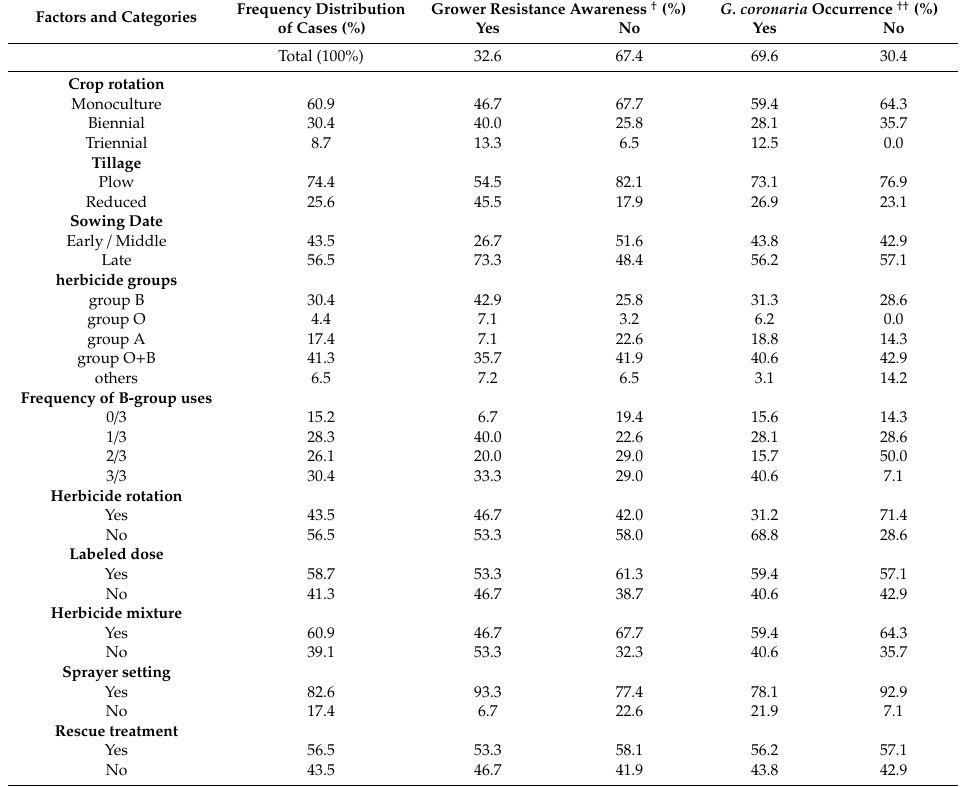
Table 1. Frequency distribution of cases (%) within each category of analyzed factors (cultural and management factors) and frequency distribution of grower resistance awareness (%) for G. coronaria (%) are shown in each